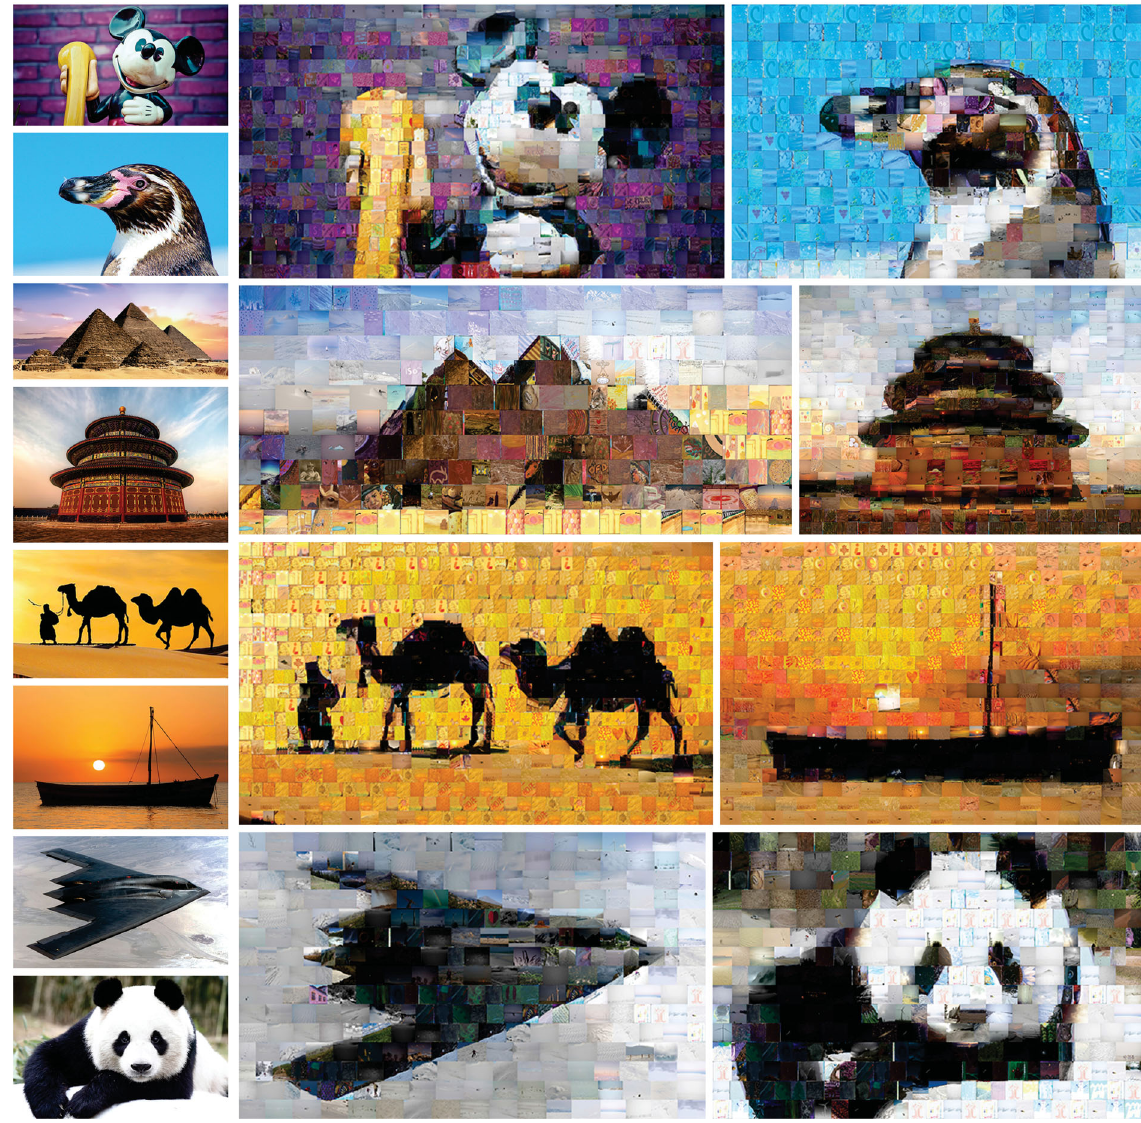
Fig. 11 Further image mosaics produced by our